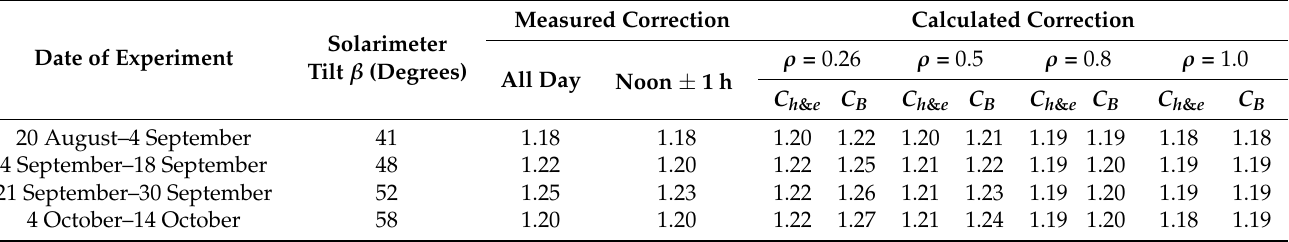
Table 2. Experimental results and comparison with calculated values of C B